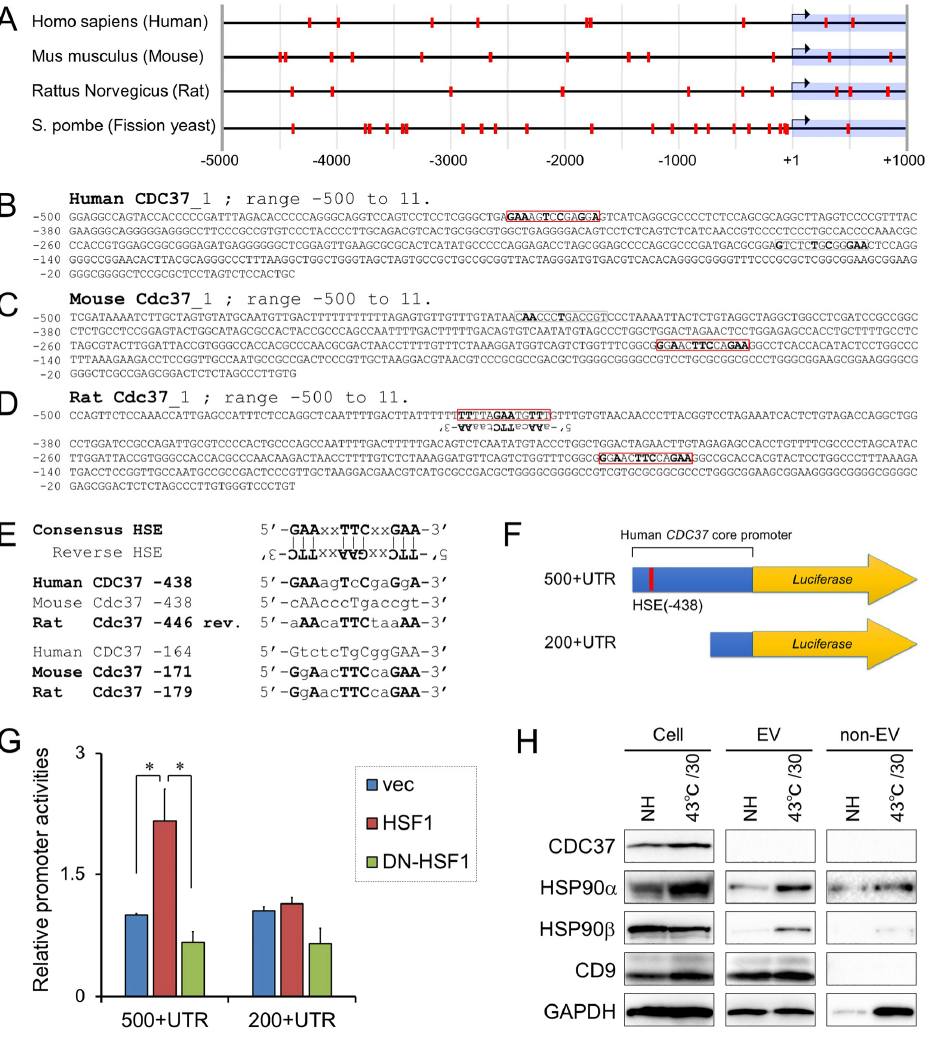
Figure 4. Heat shock response and roles of CDC37 in vesicular protein release. ( A ) Promoter analysis Figure 4 of Cdc37 ( − 5000 to + 1000) in human, mouse, rat, and fission yeast. Heat shock elements (HSE) were mapped as red boxes. ( B – D ) Mapping of HSE in Cdc37 core promoter regions ( − 500 to transcription start site) in ( B ) human, ( C ) mouse, and ( D ) rat. HSEs were enclosed with red rectangles. ( E ) Alignment of HSE conserved among mammals. The HSE( − 438) in human CDC37 is conserved with a reverse HSE( − 446) in rat Cdc37 . Another HSE( − 171) in mouse Cdc37 is conserved with the HSE( − 446) in rat Cdc37 . ( F ) Schemes of human CDC37 promoter-luciferase reporter constructs. Promoter regions (500bp + UTR or 200bp + UTR) were connected with luciferase gene. UTR, 5 (cid:48) -untranslated region. ( G ) Activities of CDC37 promoter regulated by heat shock factor 1 (HSF1). The CDC37 promoter-reporter constructs were co-transfected with overexpression constructs of HSF1 or dominant-negative (DN)-HSF1 into DU-145 cells. * p < 0.05, n = 3. ( H ) Western blot showing CDC37, HSP90, CD9, and GAPDH altered by HSS in PC-3 cells, EVs, and non-EV fraction. PC-3 cells were stimulated with or without HSS (43 °C for 30 min), cultured in serum-free media for 24 h, and then cell lysate, EV, and non-EV fractions were